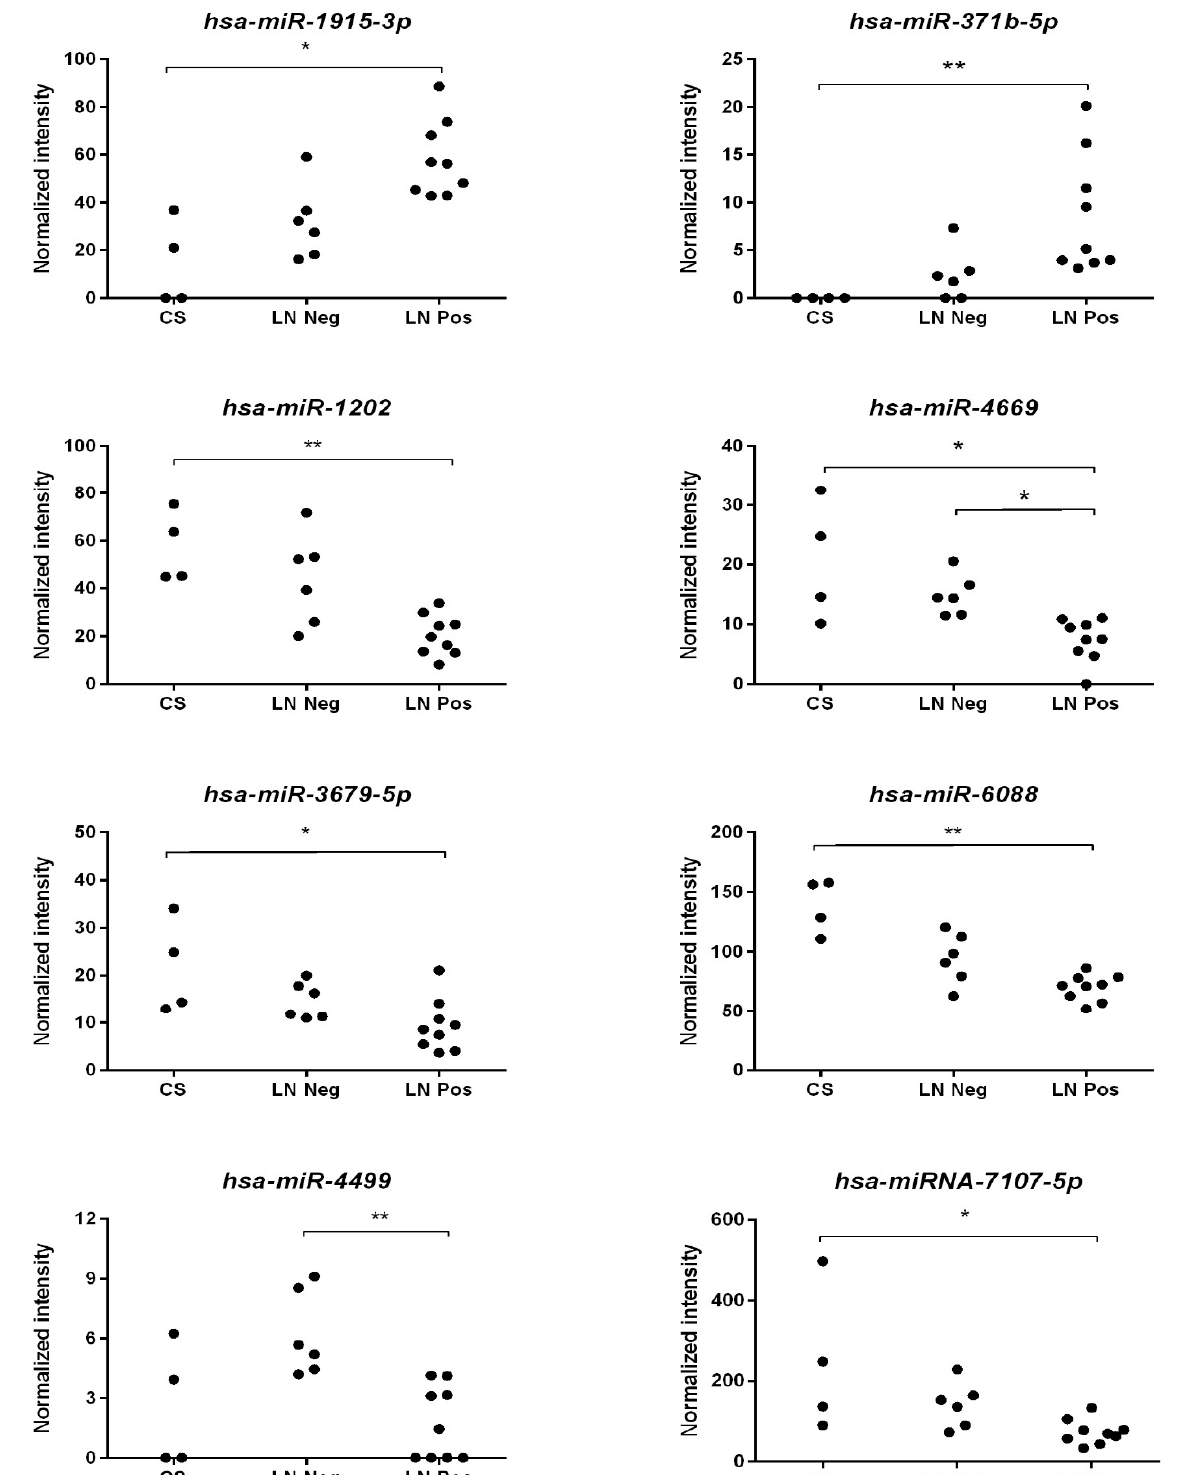
Figure 2. Expression levels of miRNAs significantly predicting adverse outcome. Normalized intensity values of miRNAs expression levels among controls (CS), PDAC patients with (LN pos) and without (LN neg) lymph node metastases have been compared. *: p < 0.05; **: p < 0.005.